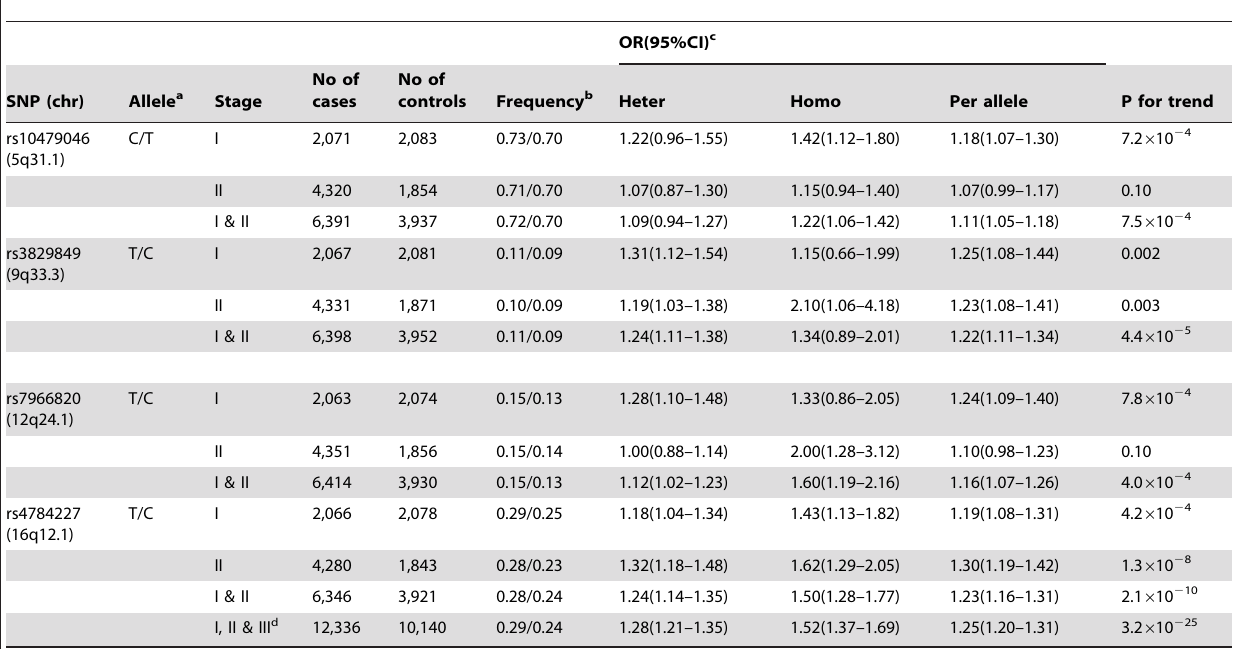
Table 2. Results from Stages I to III for rs4784227 and Stages I and II for other three SNPs that showed promising associations with breast cancer risk in Stage